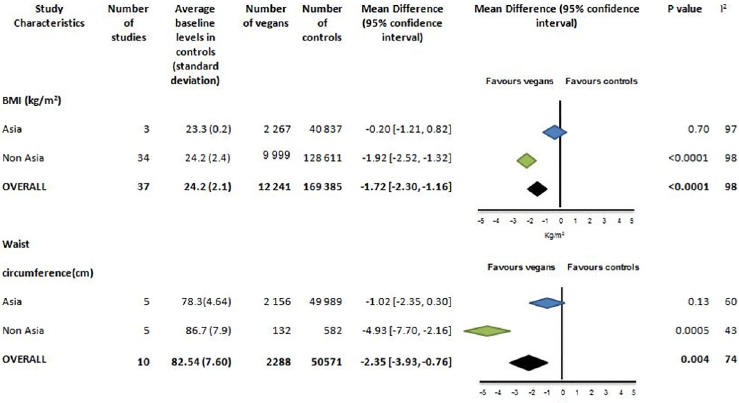
Fig 4. Body mass index (kg/m2) and waist circumference (cm) in vegans compared to omnivores.